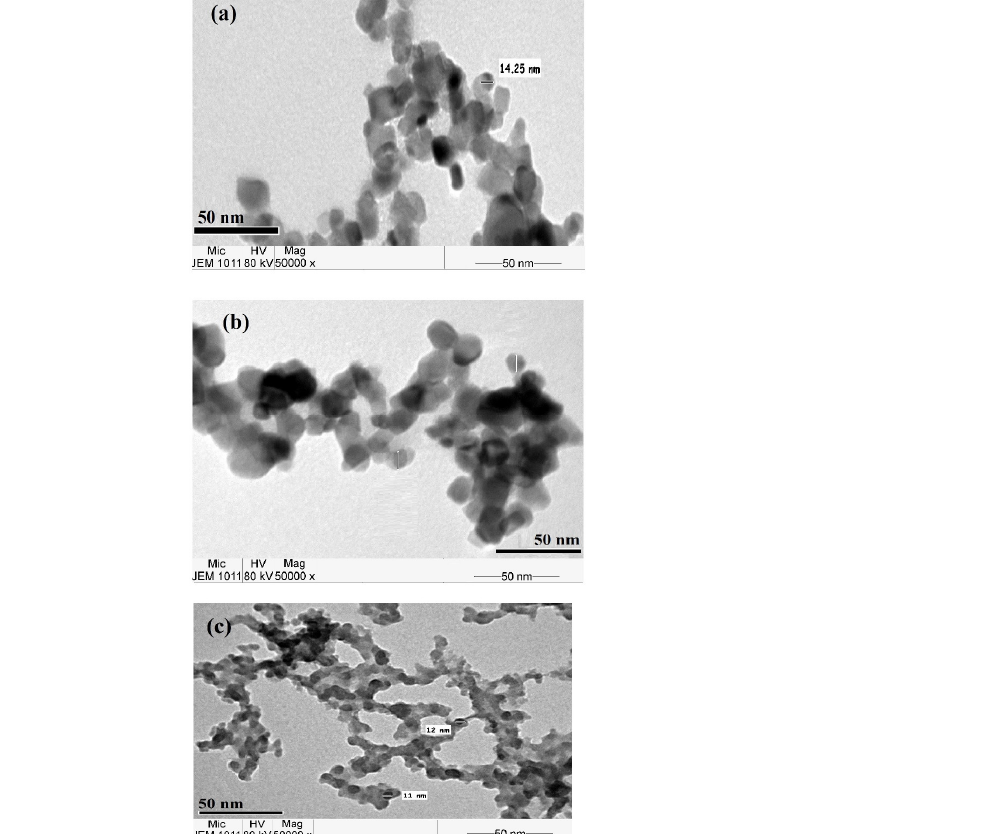
Figure 7. TEM micrographs of Fe 3 O 4 capped with ( a ) EOA, ( b ) ELOA and ( c ) ELNA.